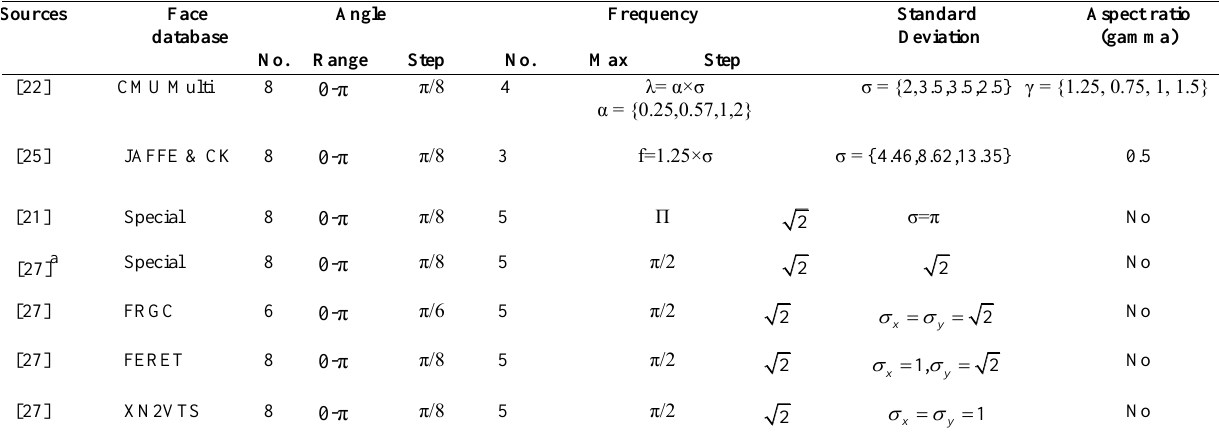
Table 1. Some of the effective parameters and their values in the Gabor filter generation used in different papers.